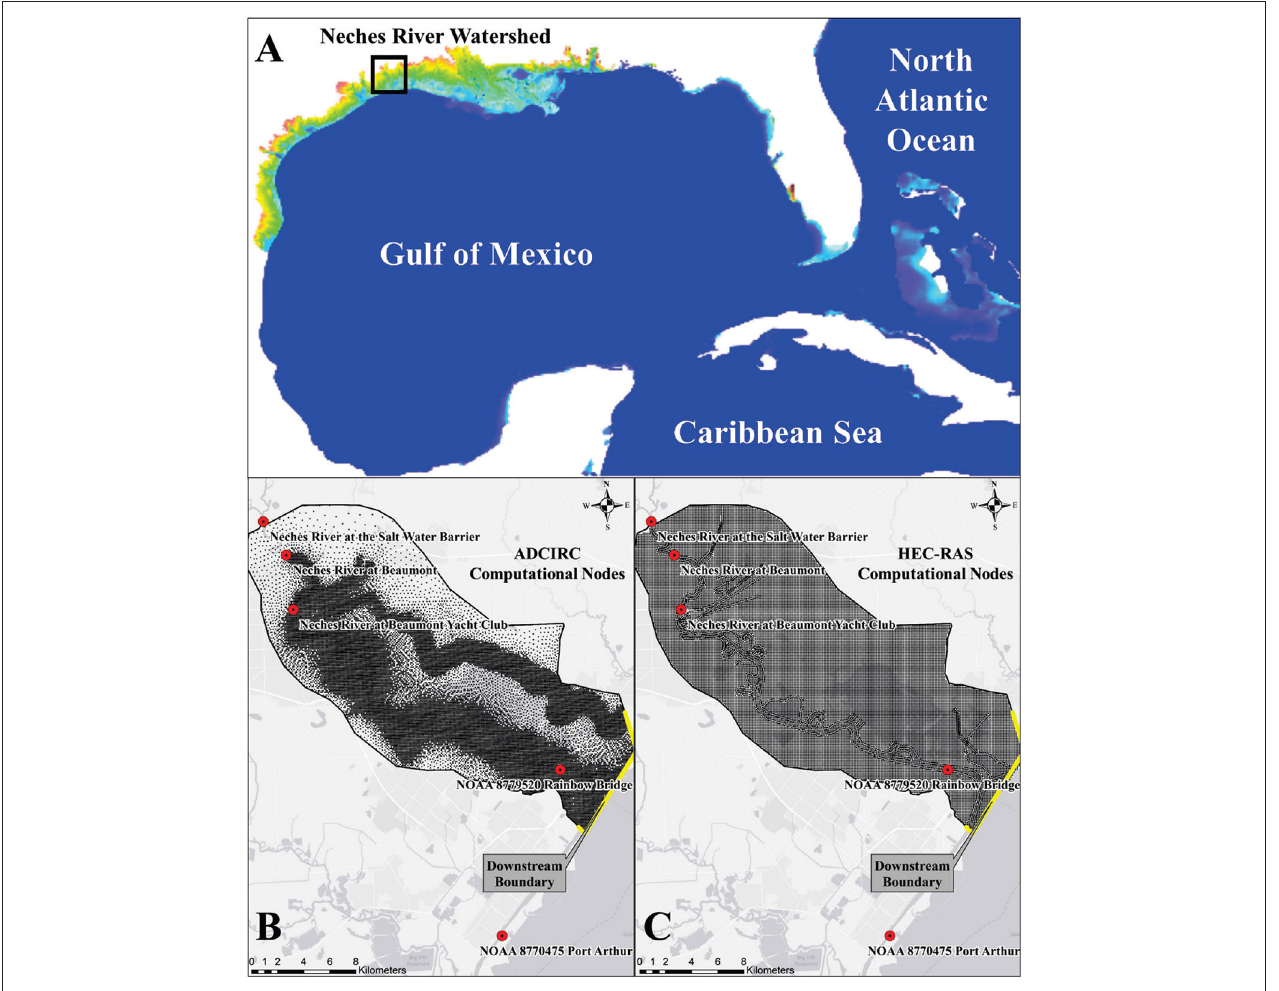
FIGURE 2 | (A) Location of the Neches River watershed within the large ADCIRC mesh that include the Gulf of Mexico and part of the north Atlantic Ocean, (B) ADCIRC small mesh structure, each black dot indicates a computational node, and (C) HEC-RAS mesh structure, the black lines separate each of the finite volume